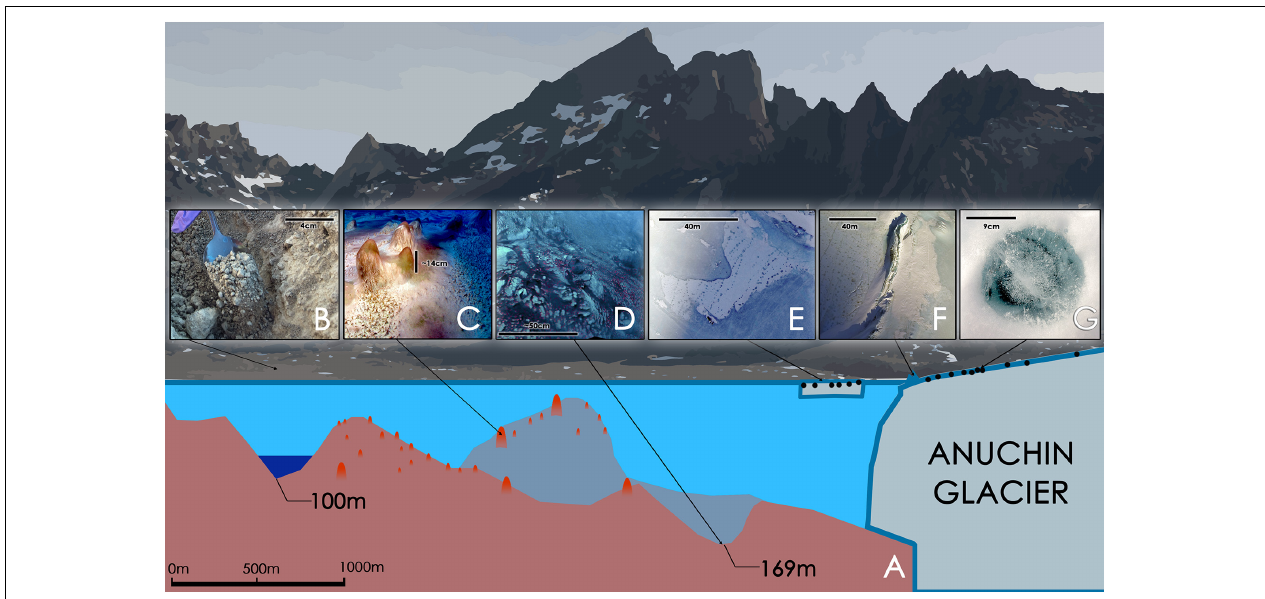
FIGURE 2 | (A) Schematic illustration of Lake Untersee with its 169 m oxic basin and a 100 m anoxic basin [illustration based on (Wand et al., 2006)]. (B) Soil sample. (C) Large conical stromatolites, pinnacle mats and flat mats at a depth of about 24 m. The scale bar is an estimate. (D) Pigmented microbial benthic mats at a depth of 169 m. The scale is an estimate. The pink dots are artifacts that were introduced during a white balance correction. They may indicate a similar surface color as seen in C . (E) “White Ice Patch” – glacial ice integrated in the lake ice containing cryoconite holes that are aligned from NE to SW; the image is oriented with North toward the top of the image. (F) Aerial image of a pressure ridge formed by the Anuchin Glacier (left) at the glacier-lake ice interface. Cryoconite holes are visible as dark dots in the glacier ice. The top left corner is orientated toward north. (G) Typical morphology of an Antarctic ice-lidded cryoconite